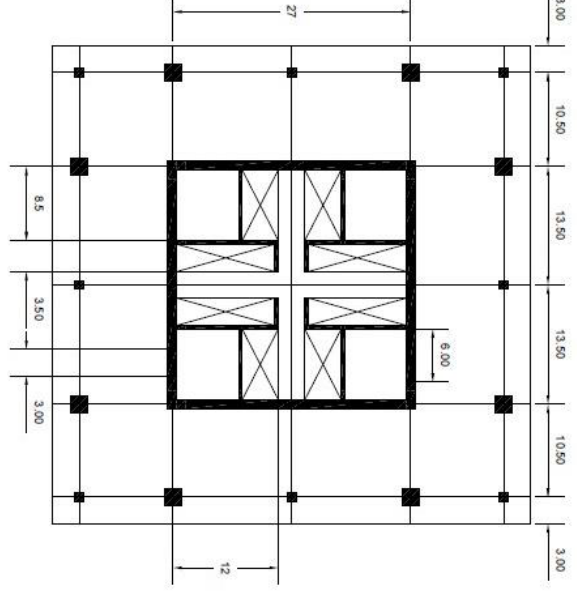
Fig. 1. Typical Plan of case